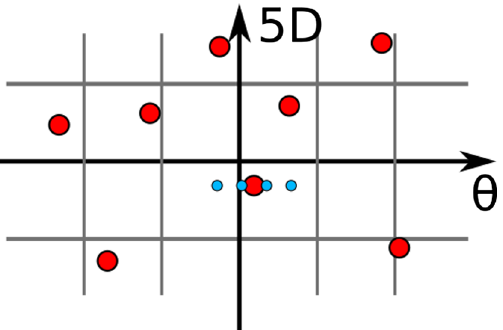
FIG. 3. Schematic description of the 6D extension methods of the 1D shot-noise modeling methods. The 5D mirroring method on the left and the 6D volume division method on the right.